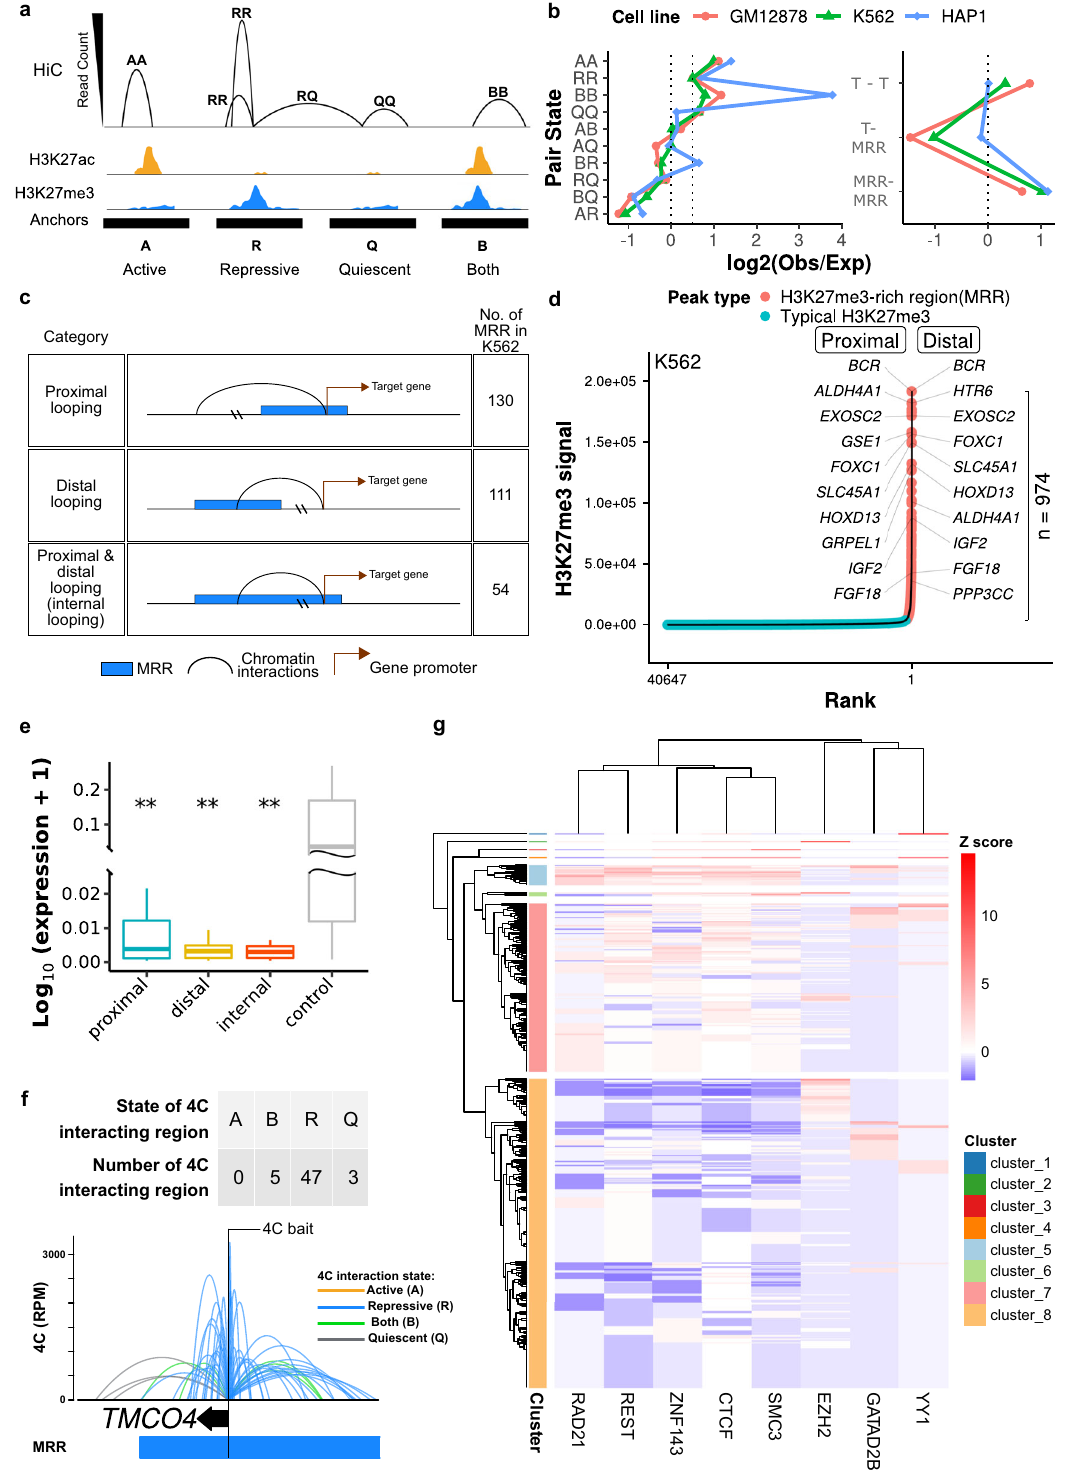
Interactions between anchors of the same state (AA, RR, and BB) were more likely to interact with each other, while interactions with vastly different chromatin state pairs (e.g., AR, BQ) were less likely to interact (Fig. 2b, left), regardless of different cell lines. When grouped into typical H3K27me3 peaks (T) versus high H3K27me3 regions or MRRs (MRR), the high H3K27me3 regions showed a preference for interactions with